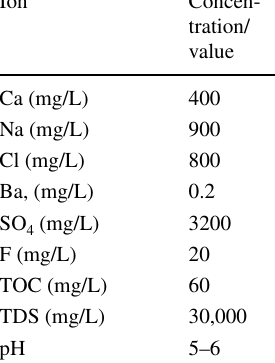
Table 2 Typical composition of RO brine from petrochemical process